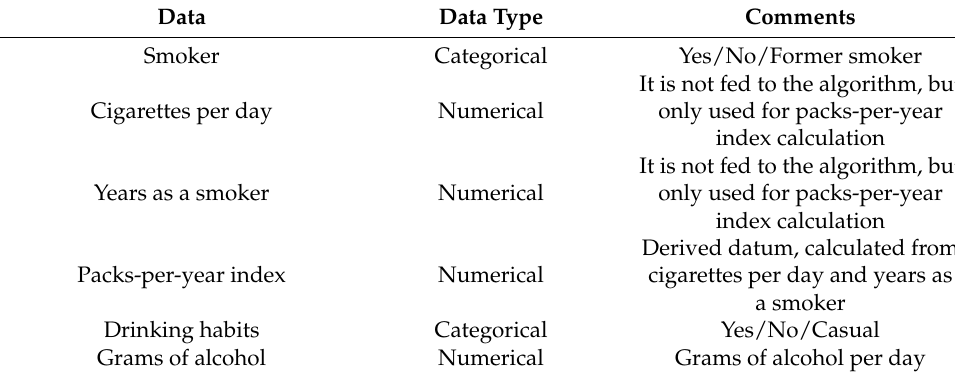
Table 3. Information related to data habits of the patient.